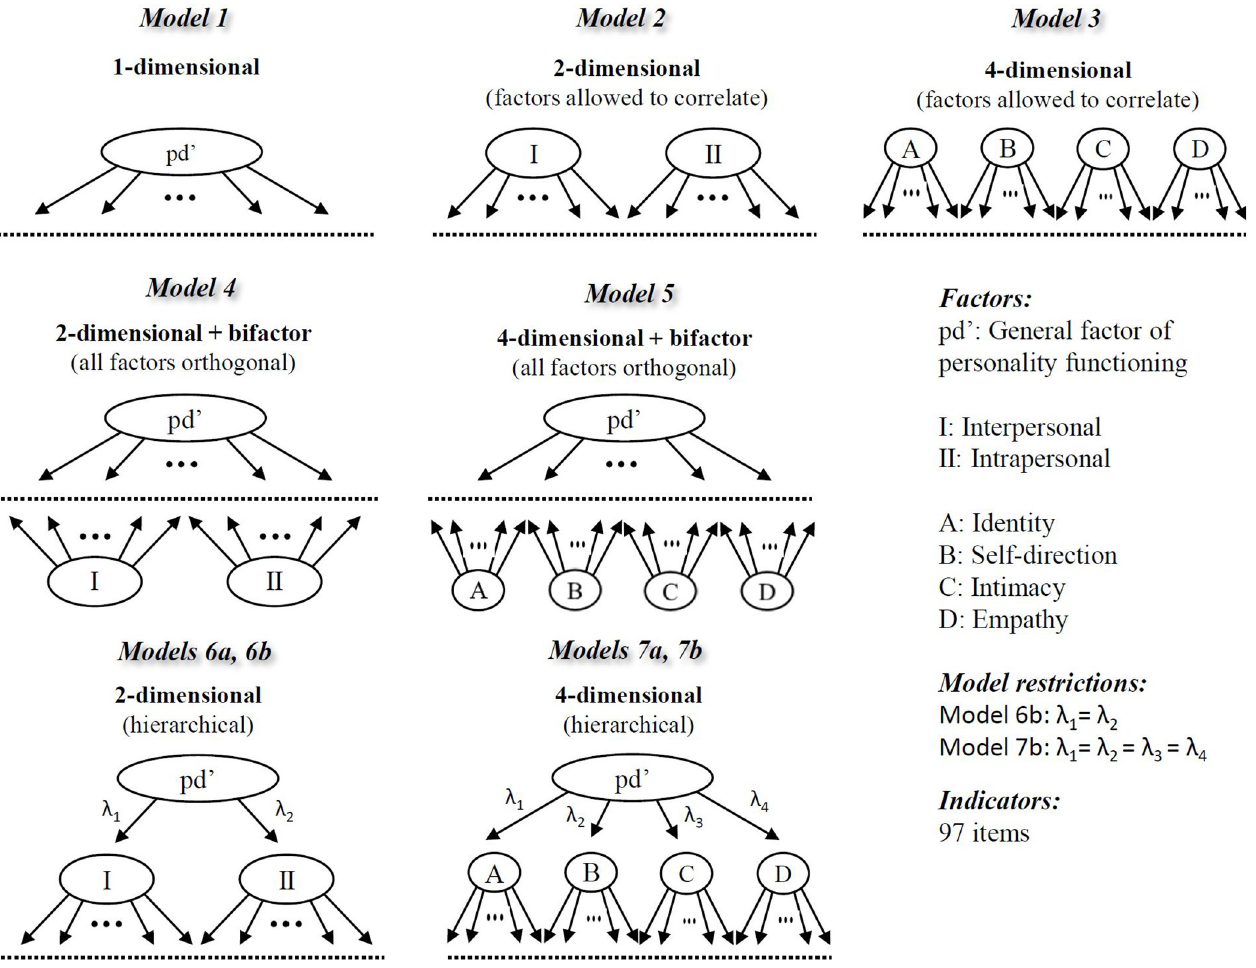
Fig 1. Different configural assumptions tested for the long